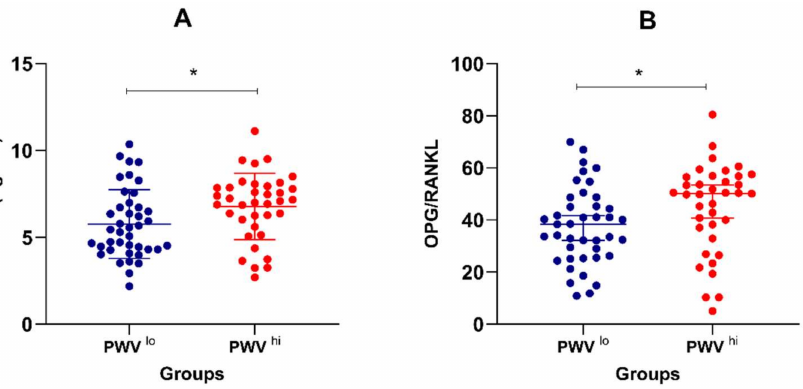
Figure 1. OPG concentrations ( A ) and OPG/RANKL ratios ( B ) in the two PWV subgroups. * p < 0.05. The prevalence of diabetes was similar in the two groups. The main clinical, functional, and laboratory parameters of the whole group and their comparisons are shown in Table